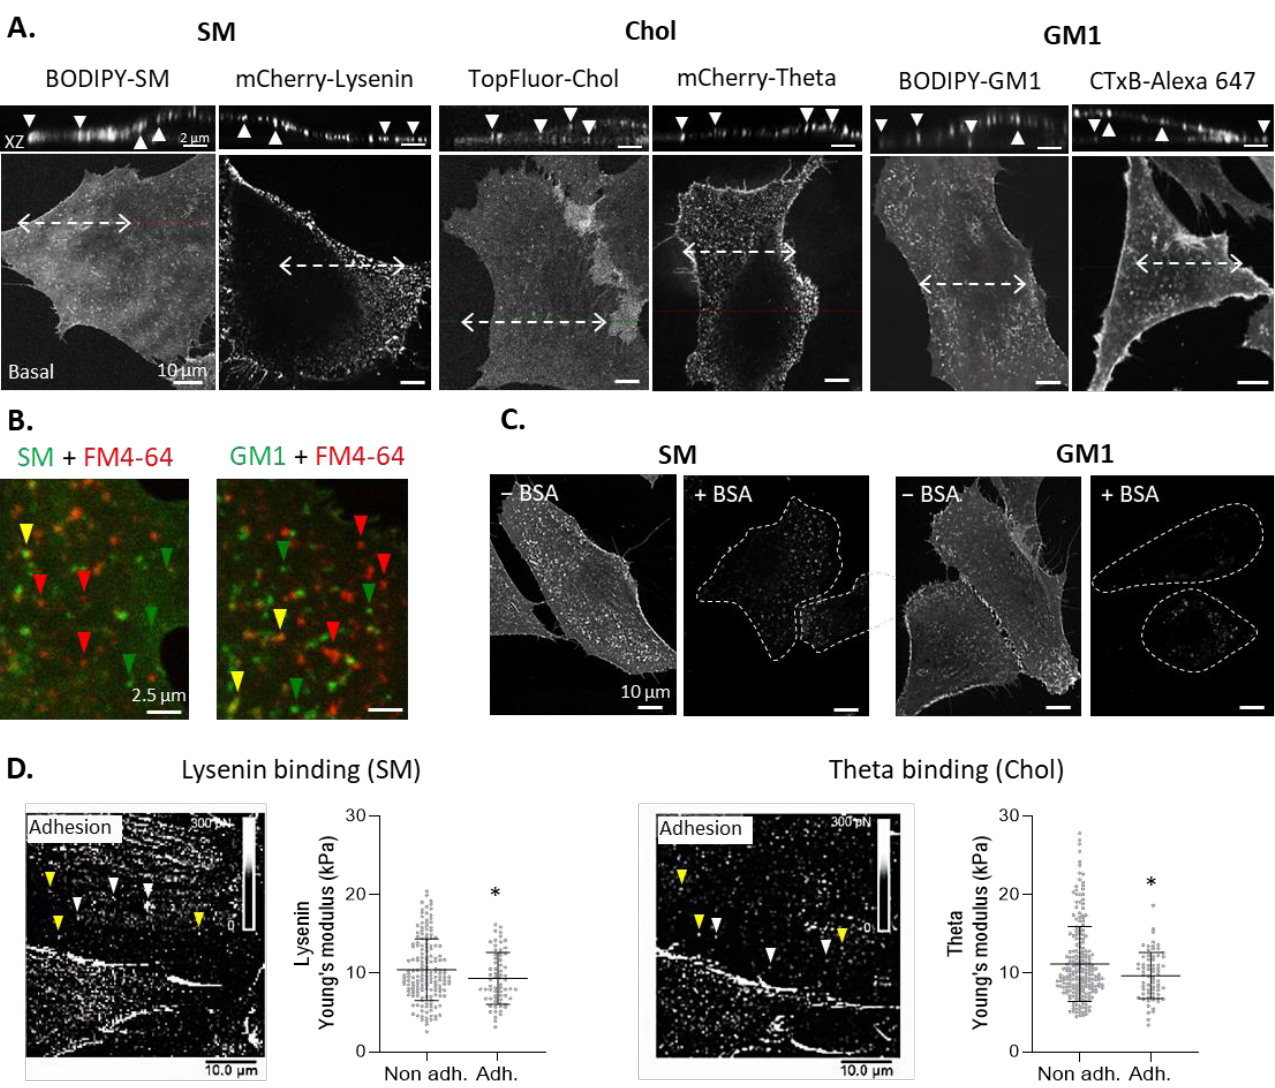
Figure 1. Clusters enriched in sphingomyelin, cholesterol, or GM1 ganglioside are revealed at the outer plasma membrane of C2C12 myoblasts and exhibit lower stiffness than the bulk membrane. ( A ) Basal confocal sections and orthogonal XZ reconstructions of cells single-labeled for SM (BODIPY- SM or mCherry-lysenin), chol (TopFluor-Chol or mCherry-theta), or GM1 (BODIPY-GM1 or Alexa 647-CTxB). Dotted arrows are cell sections for XZ reconstructions. Arrowheads are lipid clusters. Representative of >5 independent experiments for each probe except TopFluor-Chol ( n = 2). ( B ) Images of cells double-labeled for SM (BODIPY-SM) or GM1 (BODIPY-GM1) and the non-specific membrane probe FM4-64X. Green and red arrowheads are BODIPY-lipid and FM4-64X enrichments; yellow arrowheads indicate colocalization. One experiment. ( C ) Images of cells labeled for SM or GM1 (BODIPY-SM or GM1), then directly imaged (left), or treated with 5% BSA (right). Dotted lines are cell outlines. One experiment. ( D ) Cells analyzed by AFM with lysenin- and theta-coupled tips to specifically bind SM or chol. Binding events with a force > 100 pN represent adhesive areas (adh.), whereas a force < 30 pN represents non-adhesive areas (non adh; adhesion maps, right). White arrowheads have an adhesive area for one lipid; yellow arrowheads have an adhesive area for SM and chol. Young’s modulus was extracted from the information gathered by the AFM tip in adhesive and non-adhesive areas (graphs, right). The data are expressed as means ± SD ( n = 6 cells from 1 experiment with 70 measures/condition). Unpaired t -test. The statistics above for adhesive area groups refer to non-adhesive area groups.